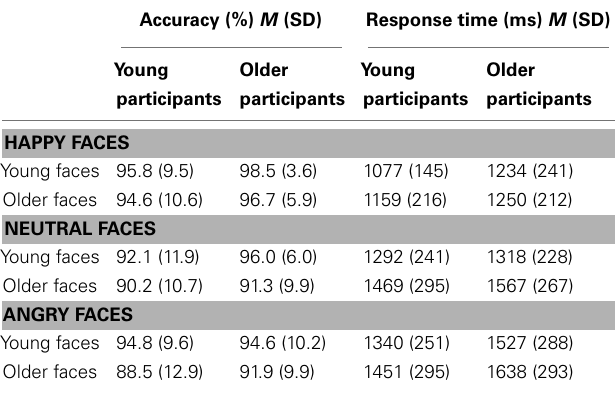
Table 3 | Means ( M ) and standard deviations (SD) for accuracy (%) and response time (ms) in expression identification of happy, neutral, and angry young and older faces for young and older